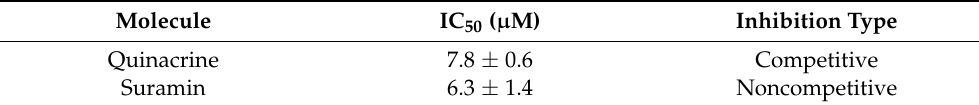
Figure 2. Inhibition effect and inhibition mode of quinacrine over SARS-CoV-2 3CL pro : ( A ) 3D representation of the 3CL pro -quinacrine complex (3CL pro are indicated by ribbon presentation, and quinacrine is represented by sticks). 3CL pro monomers are colored in green and blue, and quinacrine is colored in orange. The normalized activity and inhibition of the virus proteases, as well as Lineweaver-Burk plots to determine the inhibition mode, are presented. [S] is the substrate concentration; v is the initial reaction rate; ( B ) normalized activity and inhibition of SARS-CoV-2 3CL pro under the quinacrine influence. ( C ) Lineweaver-Burk plots for the quinacrine inhibition of SARS-CoV-2 3CL pro . Data shown are mean ± SD from 3 independent measurements ( n = 3). Table 1. Summary of the SARS-CoV-2 3CL pro inhibition experiments by quinacrine and